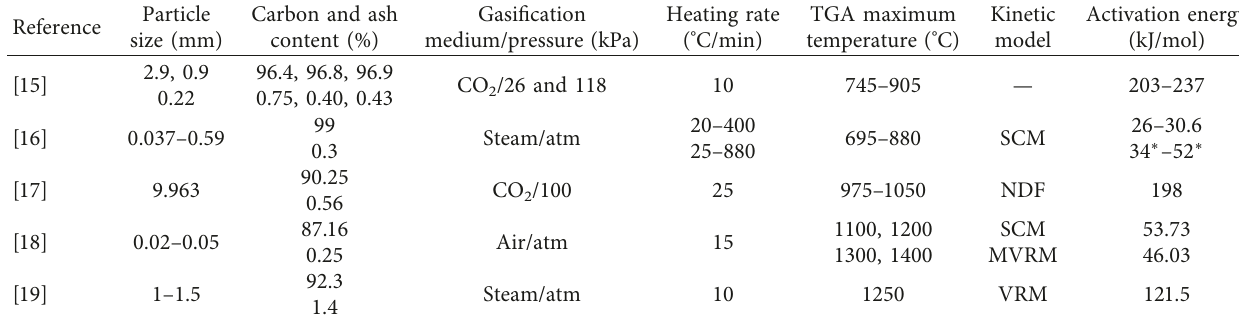
Table 1: Summary of kinetic